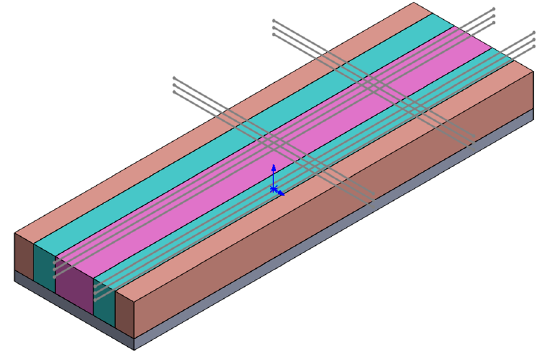
Figure 6. Schematic diagram of the test line location.